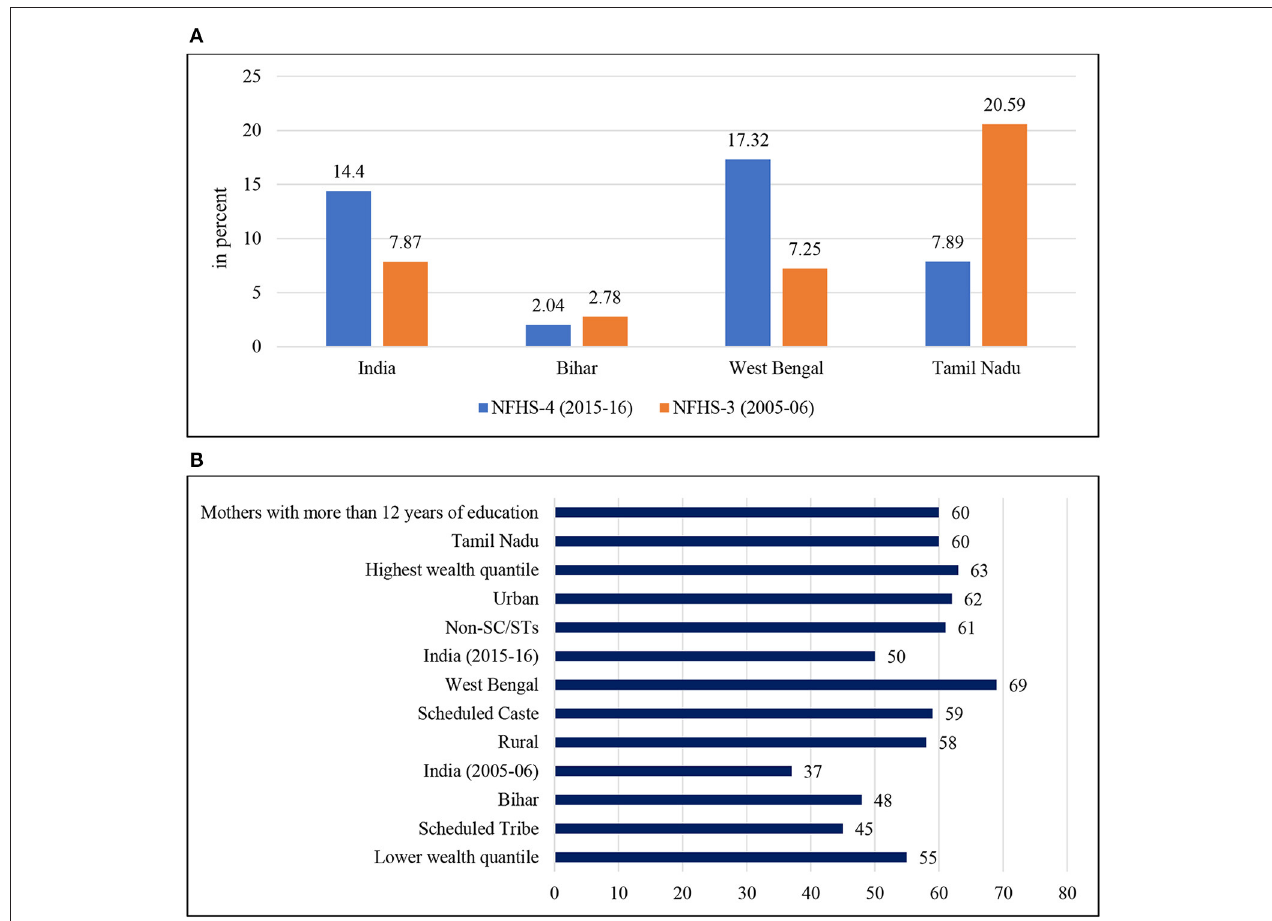
FIGURE 3 | (A) Inequalities in receiving full antenatal care (women aged 15–49 years) in India. Full Antenatal Care comprises 4 + ANC visits, 2 + TT injections, and 100 + IFA tablets. (B) Inequalities in immunization rate (full immunization of children aged 0–59 months) in India. Full immunization covers three injections each of DPT and Polio, and one injection each of BCG and